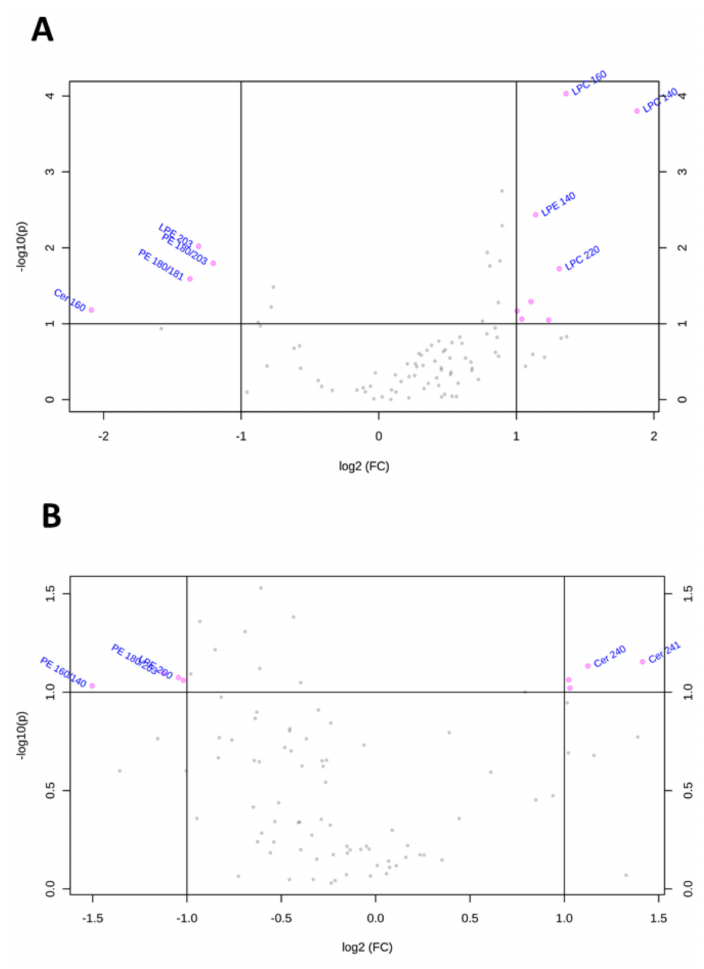
Figure 5. Changes of lipid species in Huh-7 / HepG2 cells depleted for FAK. ( A ) Important features selected by volcano plot with fold change threshold 2 and t-tests threshold 0.1 in KD HuH-7 cells. ( B ) Important features selected by volcano plot with fold change threshold 2 and t-tests threshold 0.1 in KD HepG2 cells. Note both fold changes and p -values are log transformed. Table 2. Important lipid features in Huh-7 / HepG2 cells depleted for